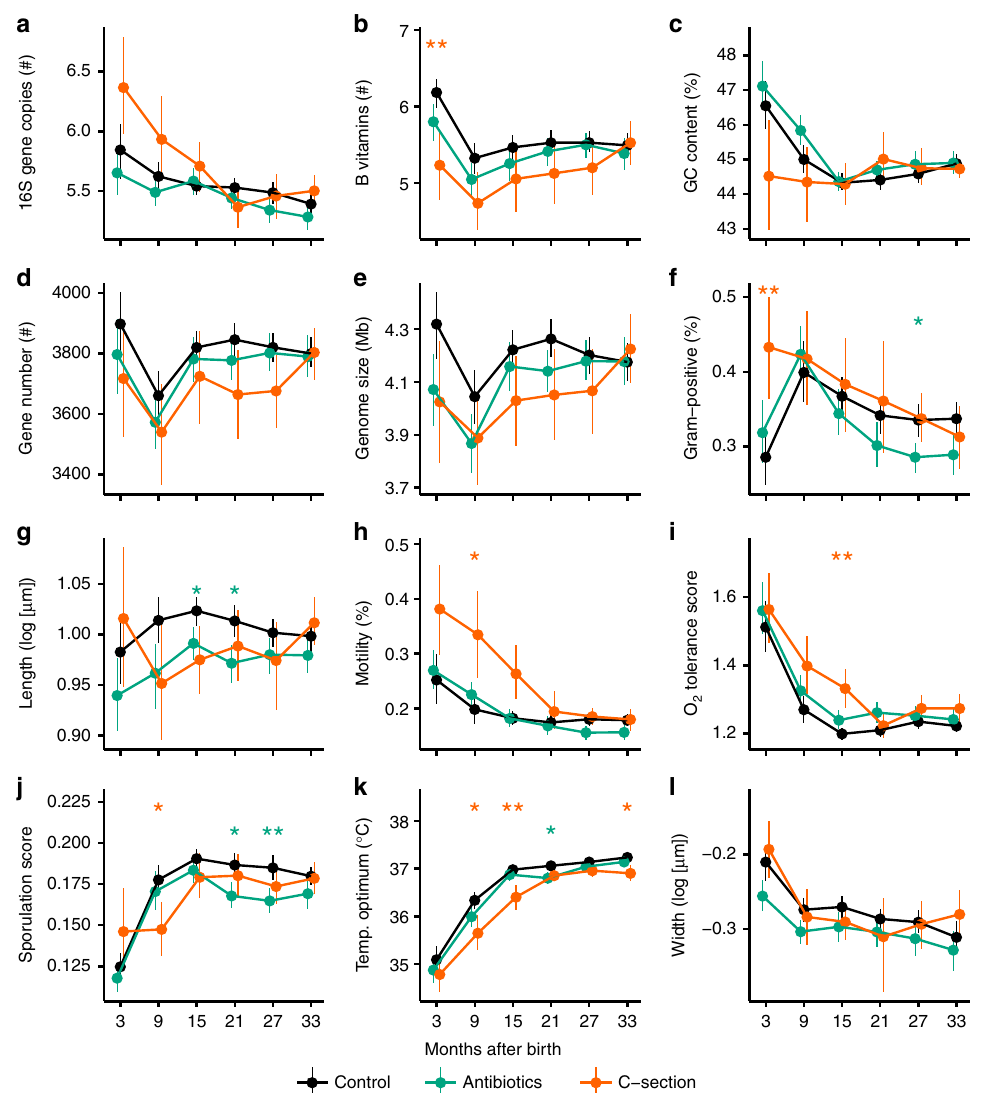
Fig. 3 Trait-based successional patterns differ by delivery mode and antibiotic history. Abundance-weighted means of predicted trait values of infant microbiomes over succession, grouped by infant delivery mode and antibiotic history ( a - l ). Filled circles show average abundance-weighted trait means of samples within 6-month periods in each cohort of infants. N is equal to the number of samples in each 6-month period; there were between 25 to 31 total samples from six infants delivered by C-section who received little to no antibiotics ("C-section" group), 66 – 91 total samples from 18 infants who were treated with antibiotics for at least 50 days ("Antibiotics" group), and 72 – 93 total samples from 18 control infants that were delivered vaginally and received no antibiotics ("Control" group). Vertical lines show 95% con fi dence intervals. Asterisks denote signi fi cance based on Welch t tests performed between each treatment group and the control group (*: adjusted p < 0.05; **: adjusted p < 0.01; ***: adjusted p <